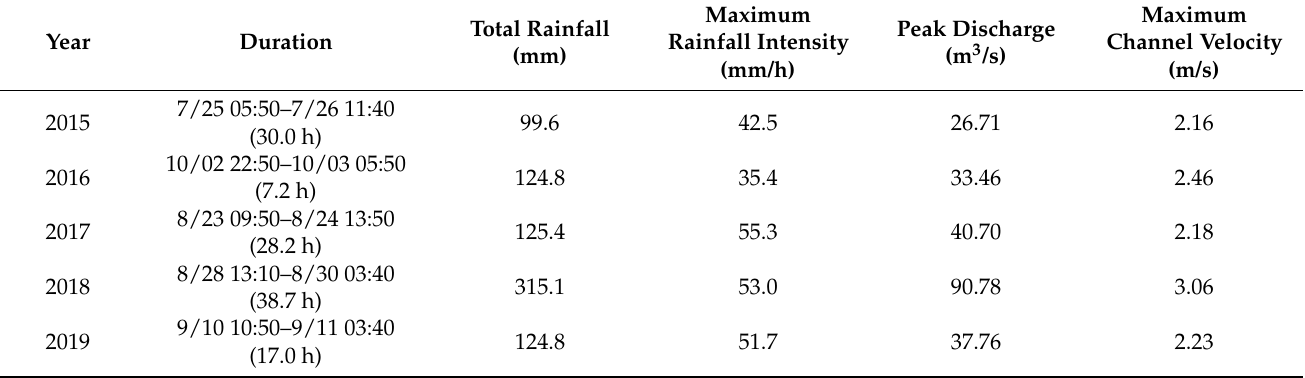
Table 2. Basic characteristics of the five rainfall-runoff events considered in this